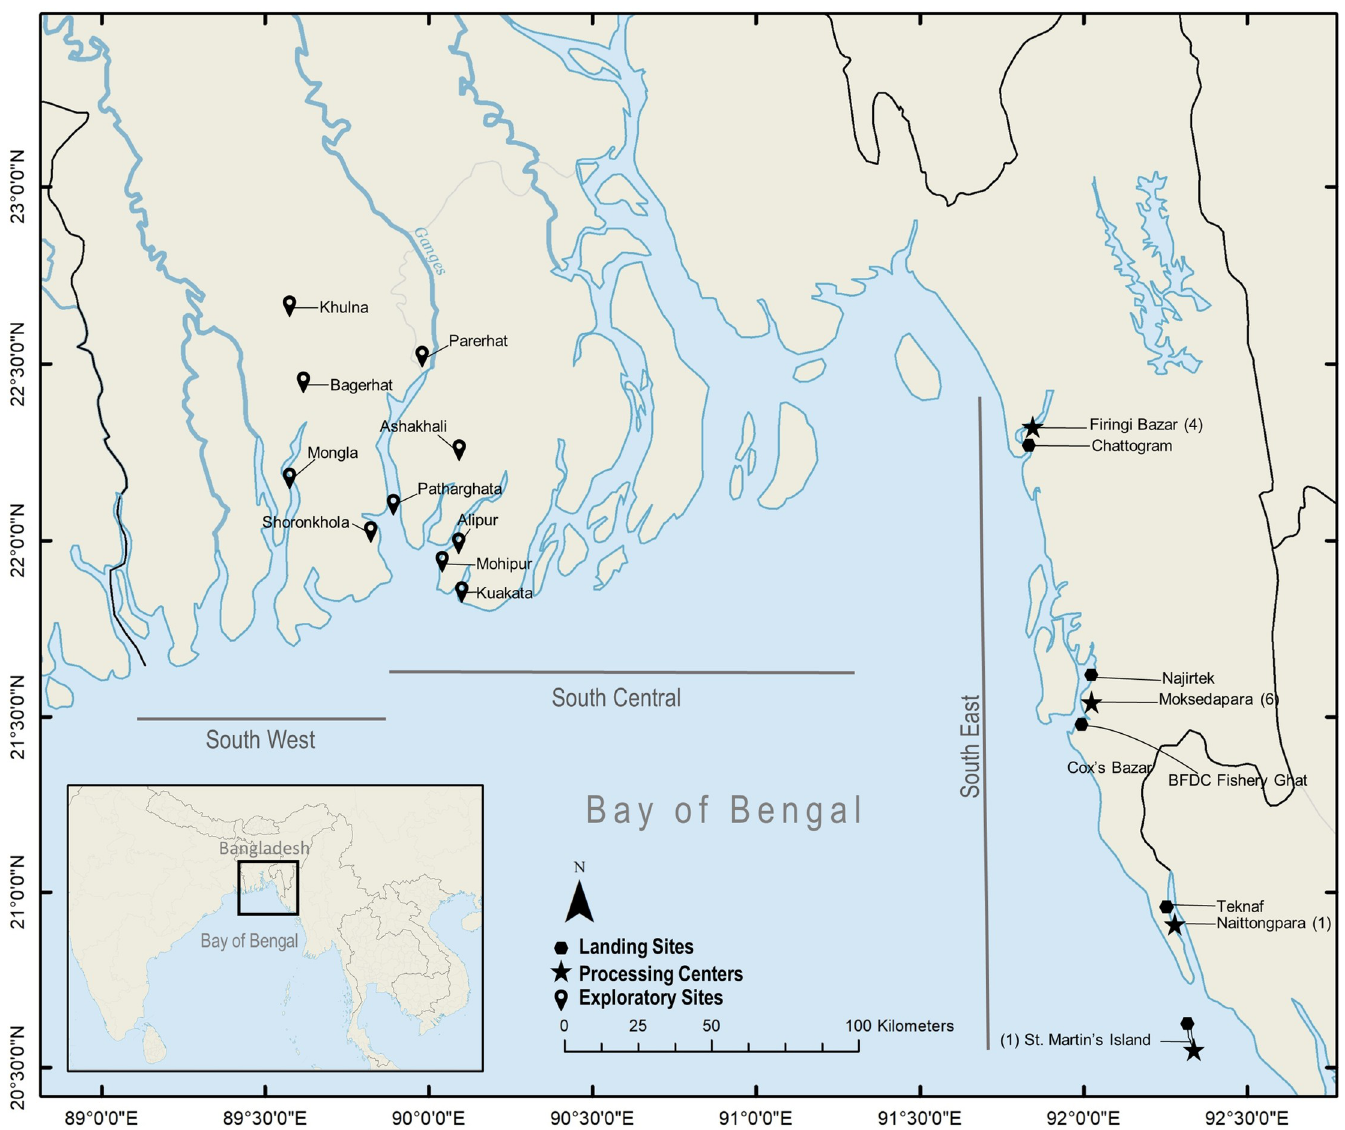
Fig 1. The inset map shows the location of Bangladesh in the Bay of Bengal. Map: The Bangladesh coastline showing the northern arm of the Bay of Bengal. Pinpoint icons show the exploratory field sites; hexagon icons indicate landings sites; and star icons indicate the processing centres, along the south-eastern coastline of